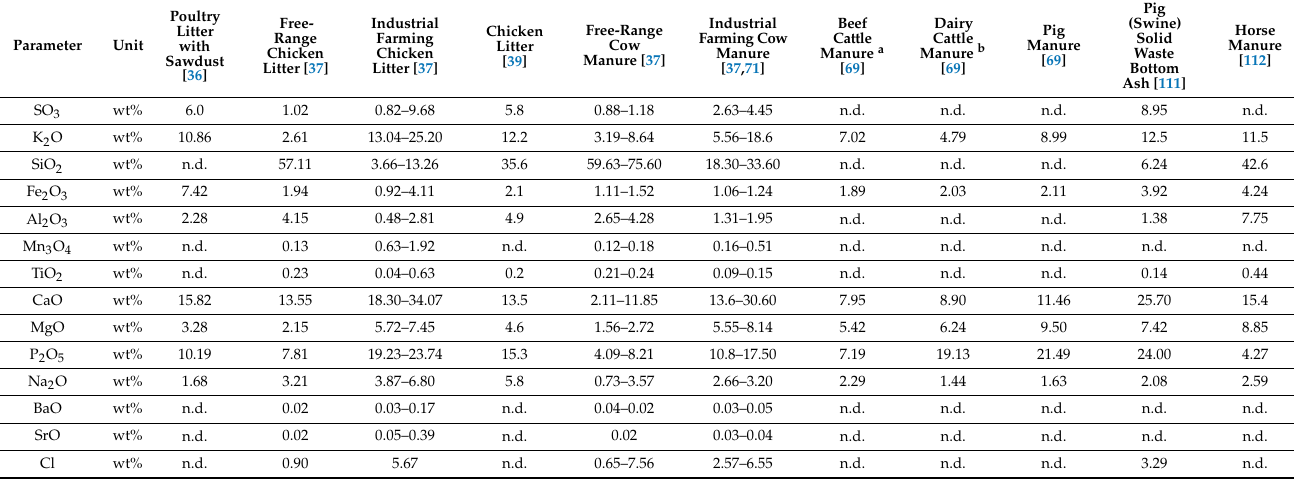
Table 3. Animal-origin waste ashes compositions (n.d.—no